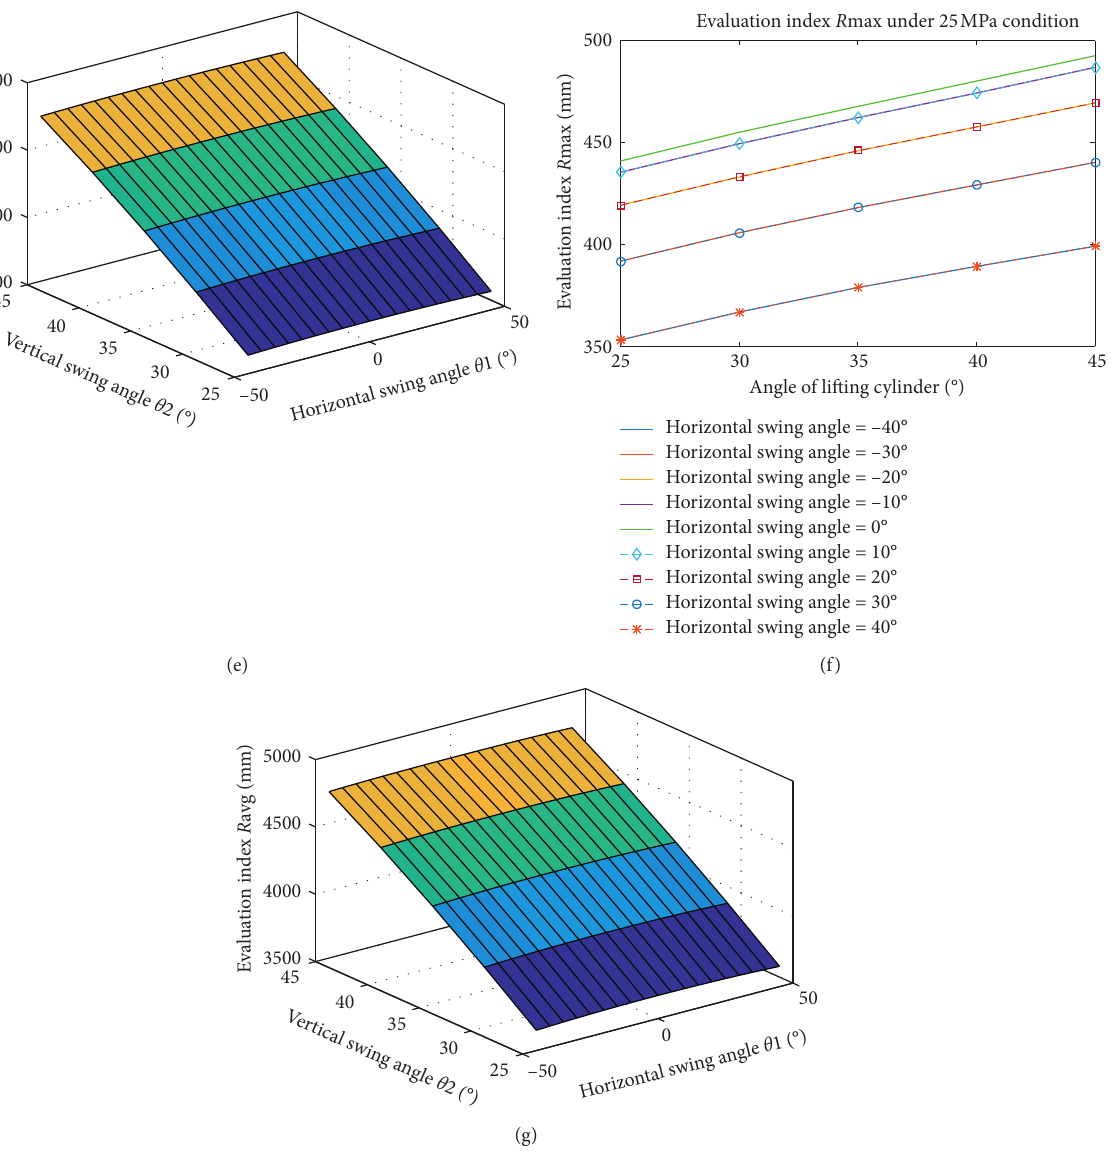
Figure 11: Evaluation indexes of outline features of roadway forming under different working conditions. (a) Three-dimensional diagram. (b) Evaluation index R max under 18MPa condition. (c) Evaluation index R avg under 18MPa condition 18MPa. (d) Evaluation index R max under 20 MPa condition. (e) Evaluation index R avg under 20MPa condition. (f) Evaluation index R max under 25MPa condition. (g) Evaluation index R avg under 25MPa